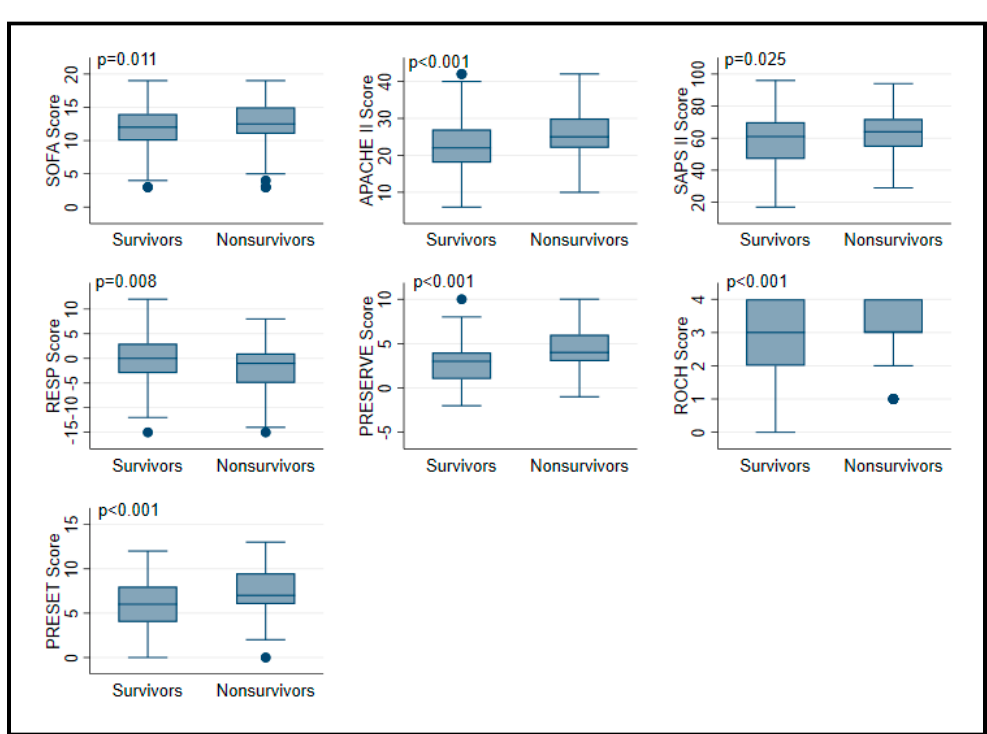
Figure 4. Boxplot of prognostic score values in in patients supported with veno-venous extracorporeal membrane oxygen- ation according to survivors and non-survivors. Data are expressed as median, minimum, maximum, 25. percentile, and 75. percentile.